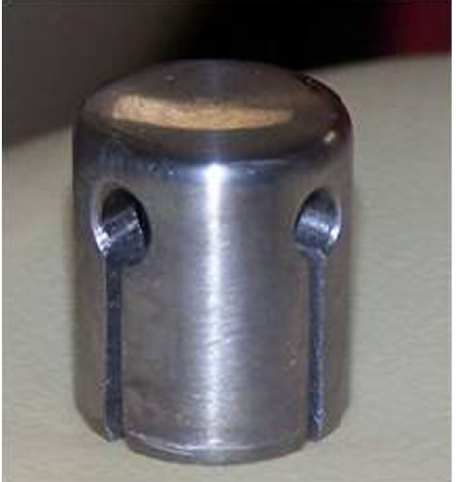
FIG. 3. Niobium cathode. The machined holes and slots on each side of the cathode allow insertion of a tool used to press the cathode into the cathode stalk, and allow the cathode base to flex for a tight fit during insertion. In this way, the cathode can be inserted without risking damage to its emitting